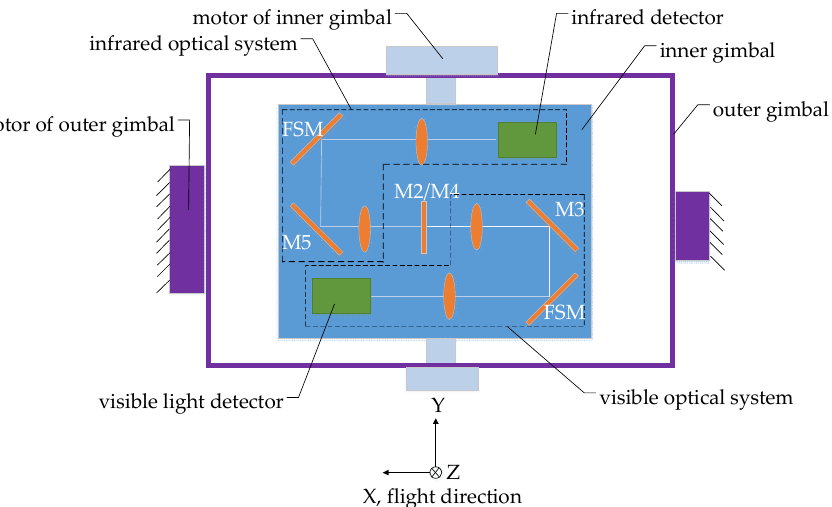
Figure 1. Composition of the dynamic scan and stare imaging system.